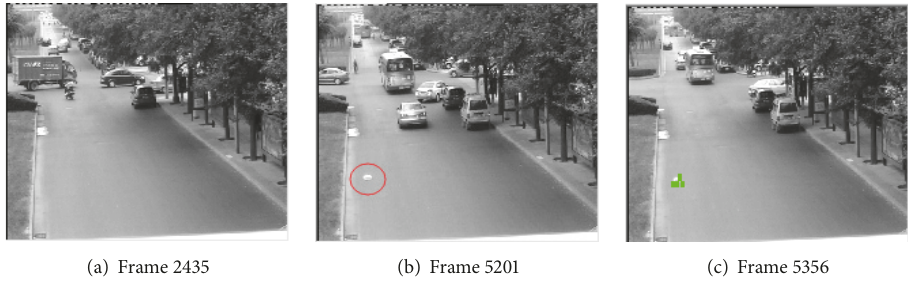
Figure 11: Results of detecting the dropping in the bus lane of South Second Ring Road in Xi’an.